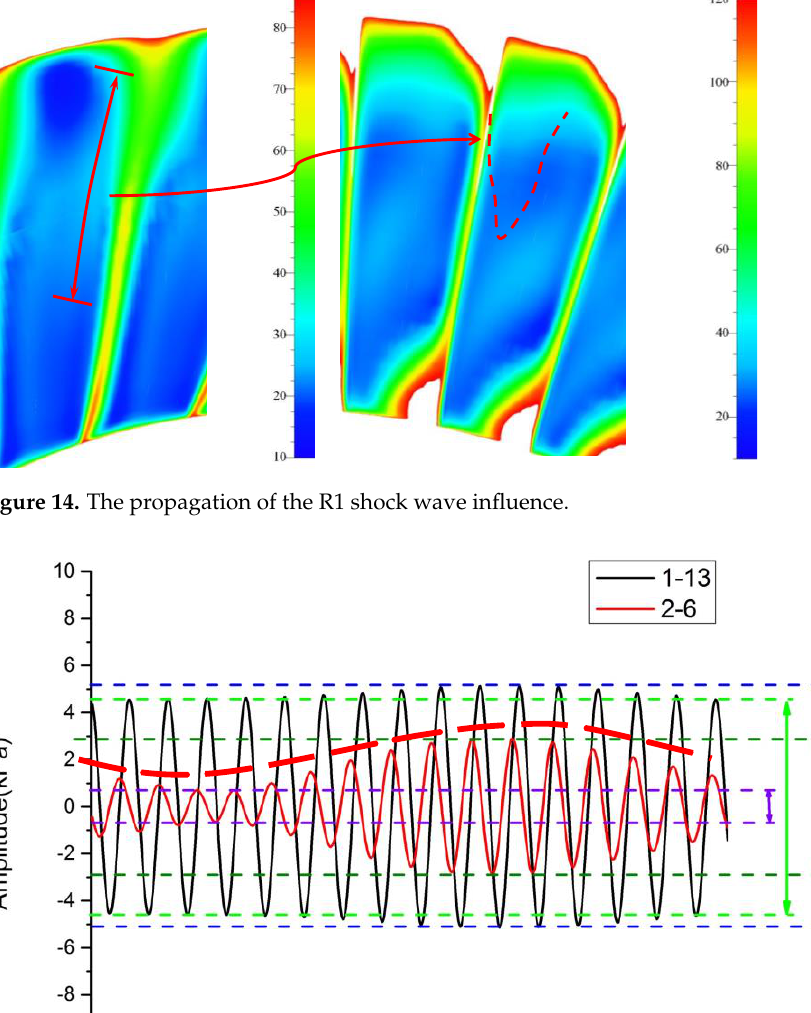
Figure 16. The comparison of the 2BPF disturbance of the R1 blade sweep between locations 1-13 and 2-6 .